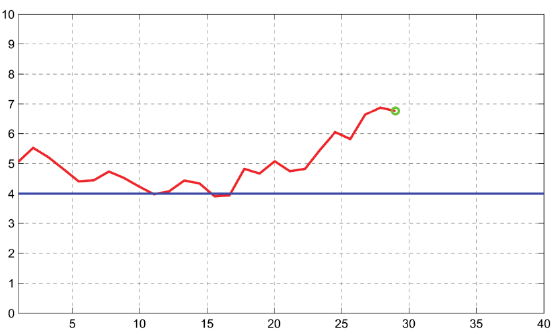
Figure 4. Graph shown to the volunteers during the neurofeedback training. An example from one of